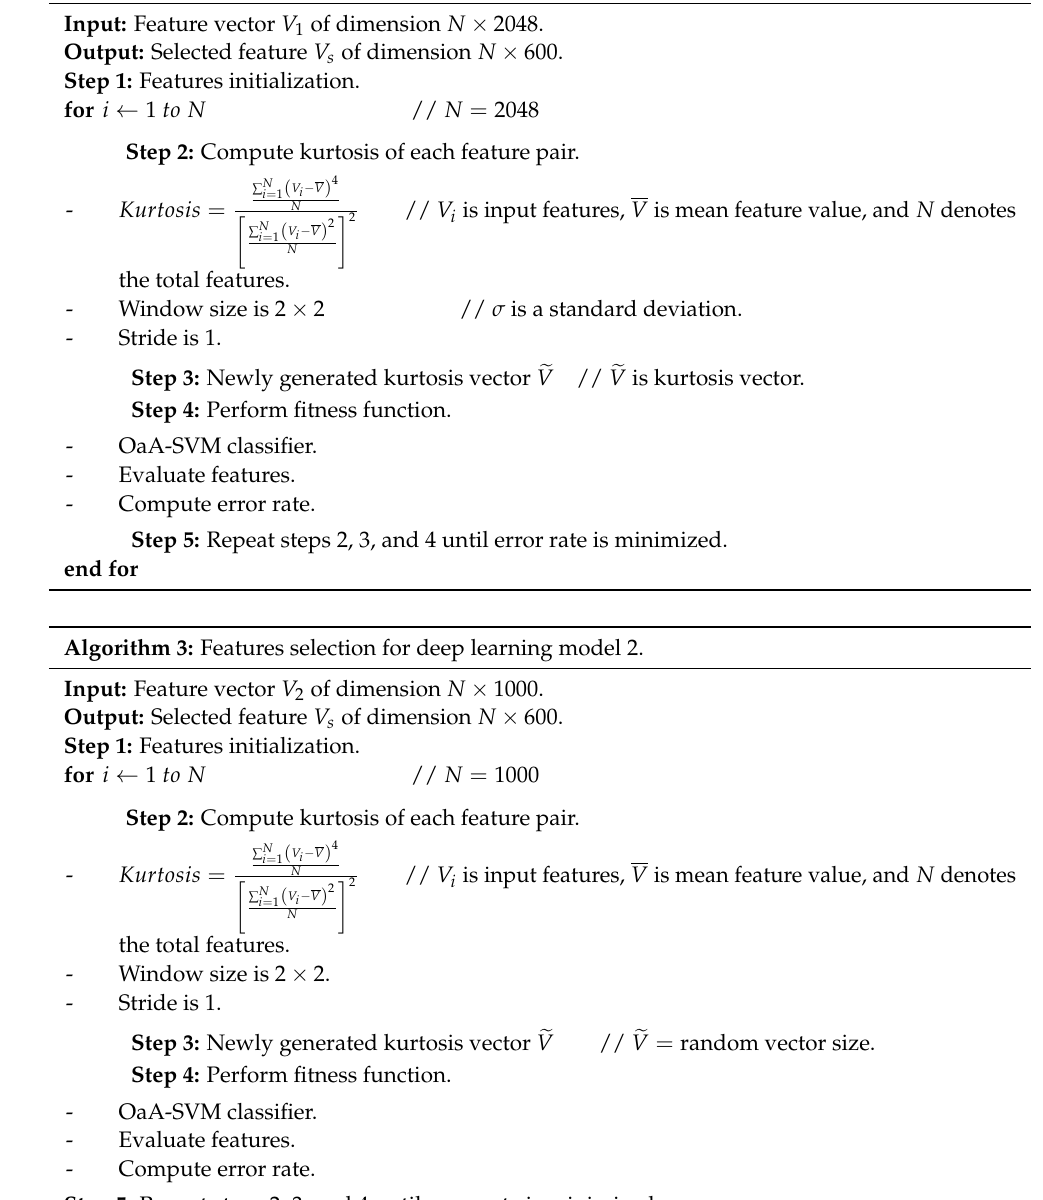
Algorithm 2: Features selection for deep learning model 1.